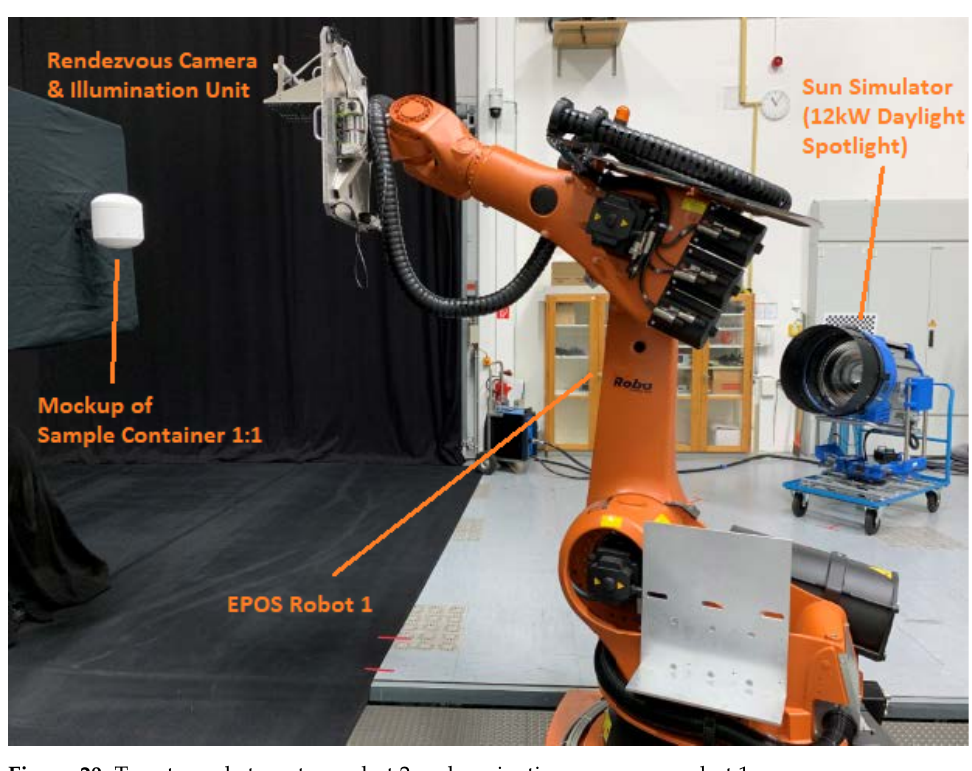
Figure 20. True-to-scale target on robot 2 and navigation camera on robot 1.